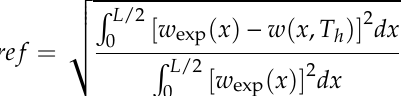
Figure 3. Examples of load distributions depending on parameter